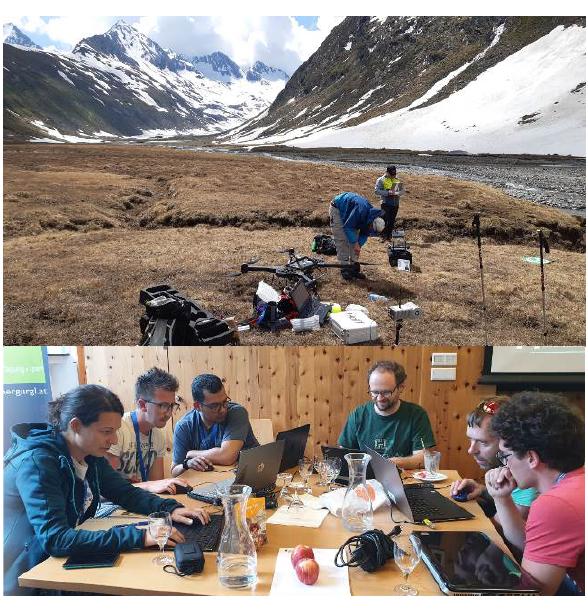
Figure 2. For assignments all sensors and platforms have to be carried to the field site of interest (top), sensors on hand-held, terrestrial and UAV-platforms have been studied (top) and finally data has been processed and analysed by participants (bottom).